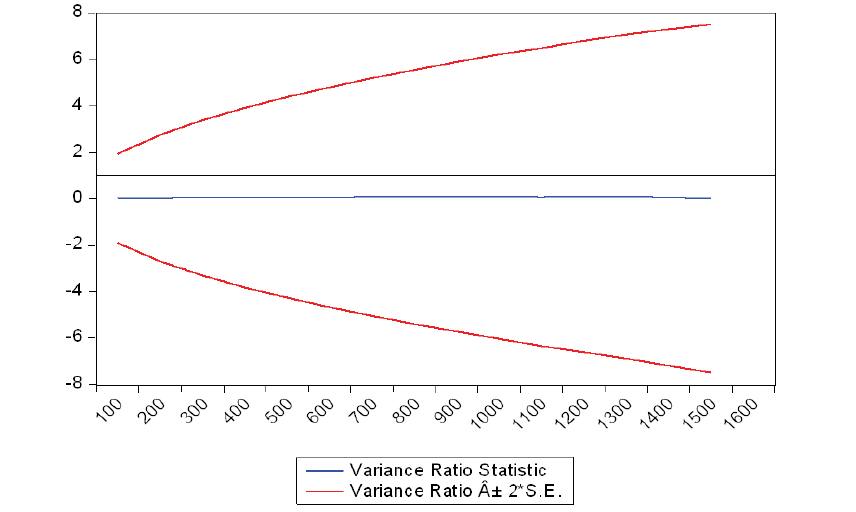
Fig. 3. Graphical illustration of the efficiency of the DSE share index daily data over the test periods (January 2009 to August 2015)